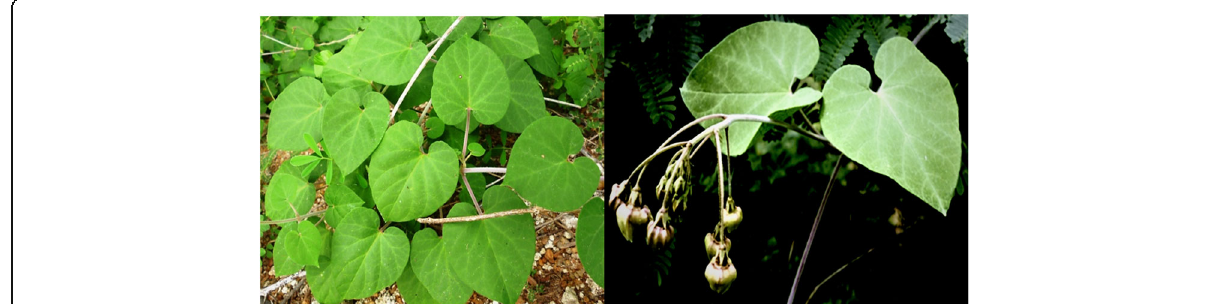
Fig. 2 Pergularia daemia